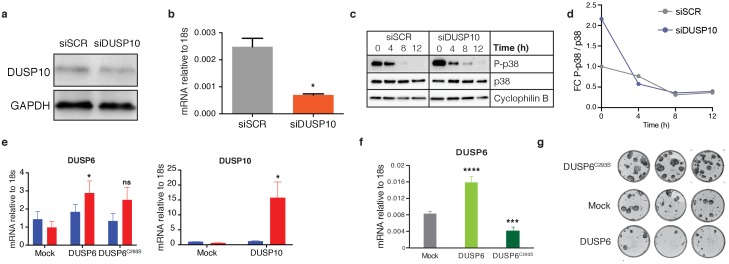
Effects of DUSP10 knockdown and DUSP6 and DUSP10 over-expression.(a, b) Western blot (a) and RT-qPCR measurements (b) of DUSP10 knockdown by SMART pool siRNA. p-values were generated by one-tail t-test. (c, d) Western blot of phospho-p38 and total p38 in suspended cells following DUSP10 knockdown. siSCR, cyclophilin B loading control and quantitation are shown. (e) RT-qPCR quantification of doxycycline-induced over-expression of DUSP6, mutant DUSP6C293S and DUSP10 relative to 18 s mRNA. Cells were treated with 1 µg/ml doxycycline for 24 hr. p-values were generated by a one-tail t-test. (f) RT-qPCR quantification of Cumate-induced over-expression of DUSP6 and mutant DUSP6C293S relative to 18 s mRNA. p-values were generated by one-way ANOVA. (g) Representative dishes showing effects of overexpressing wild type and mutant DUSP6 on clonal growth (representative of n = 3 dishes). (b, e, f) Error bars represent s.d. *p<0.05; ***p<0.0005; ****p<0.0001; ns = non significant.